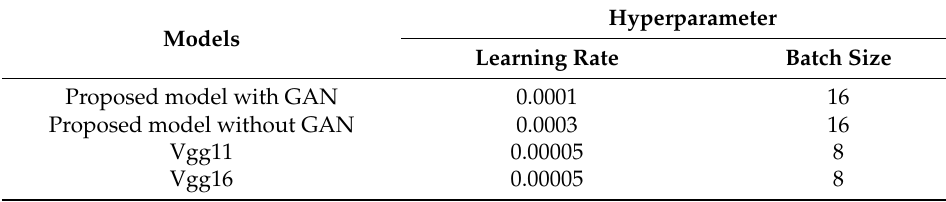
Table 8. Hyperparameter selection for different